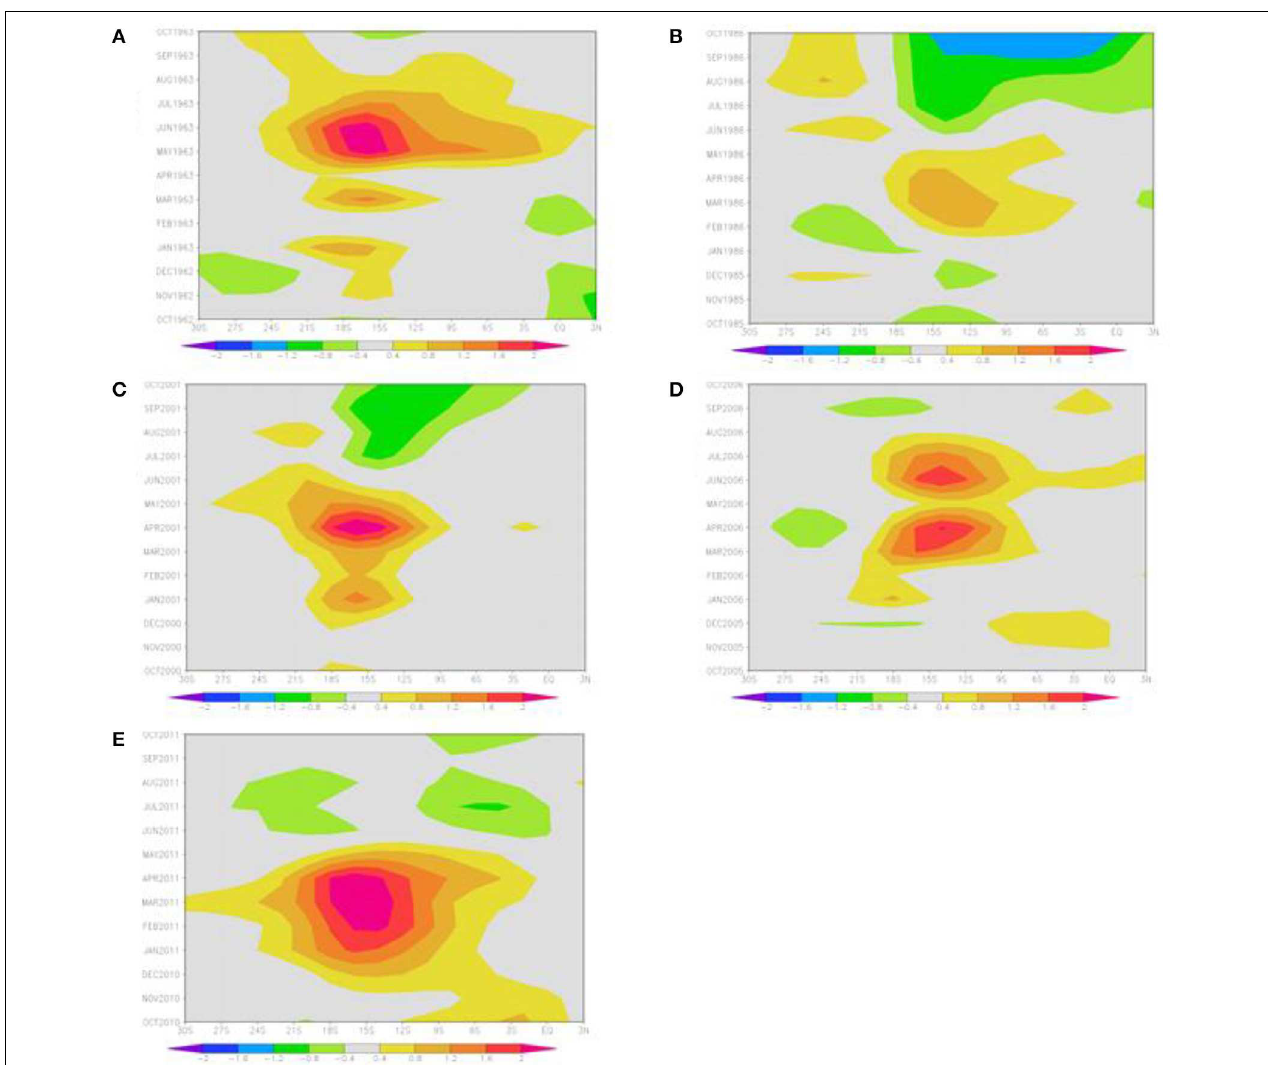
FIGURE 5 | Hovmoller plot of SST anomaly ( ◦ C) along 10 ◦ E from 30 ◦ S to 3 ◦ N for the five strong events (A) 1963, (B) 1986, (C) 2001, (D) 2006, (E) 2011 from October of the preceding year to October of the event year.